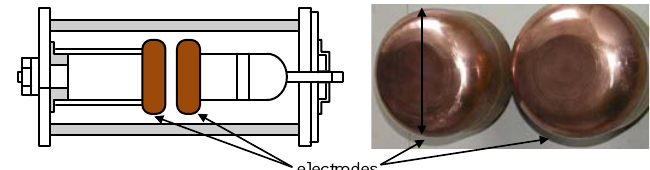
Figure 3. Drawing of the test tooling and pictures of plate electrodes.